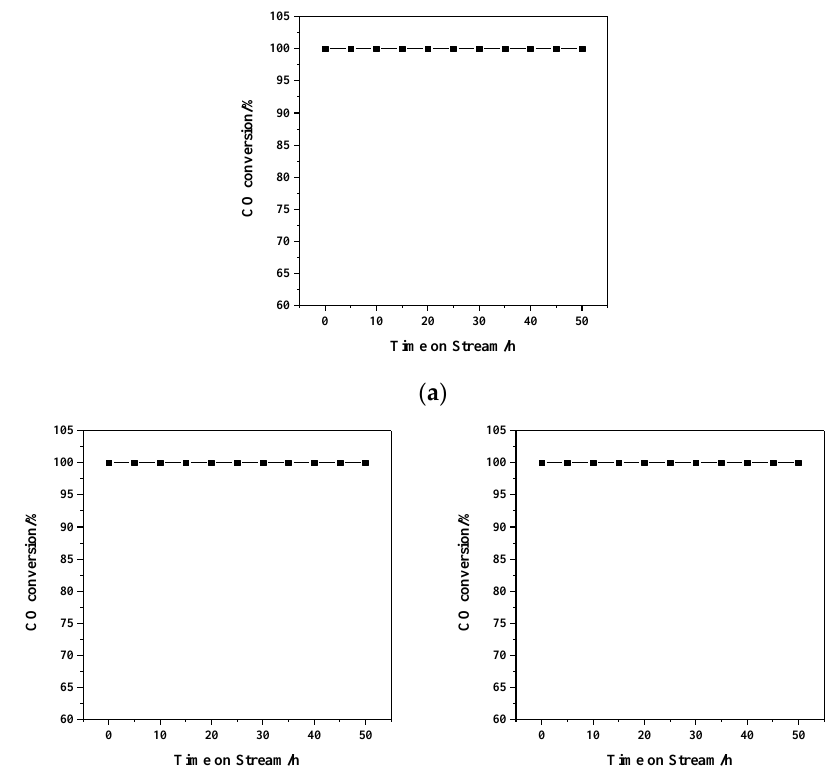
Figure 10. The high-temperature stability of 1.86% Au/α-Fe 2 O 3 catalyst calcined at 300 °C for 2 h, at the CO oxidation reaction temperature of ( a ) 100 °C, ( b ) 140 °C, ( c ) 180 °C.